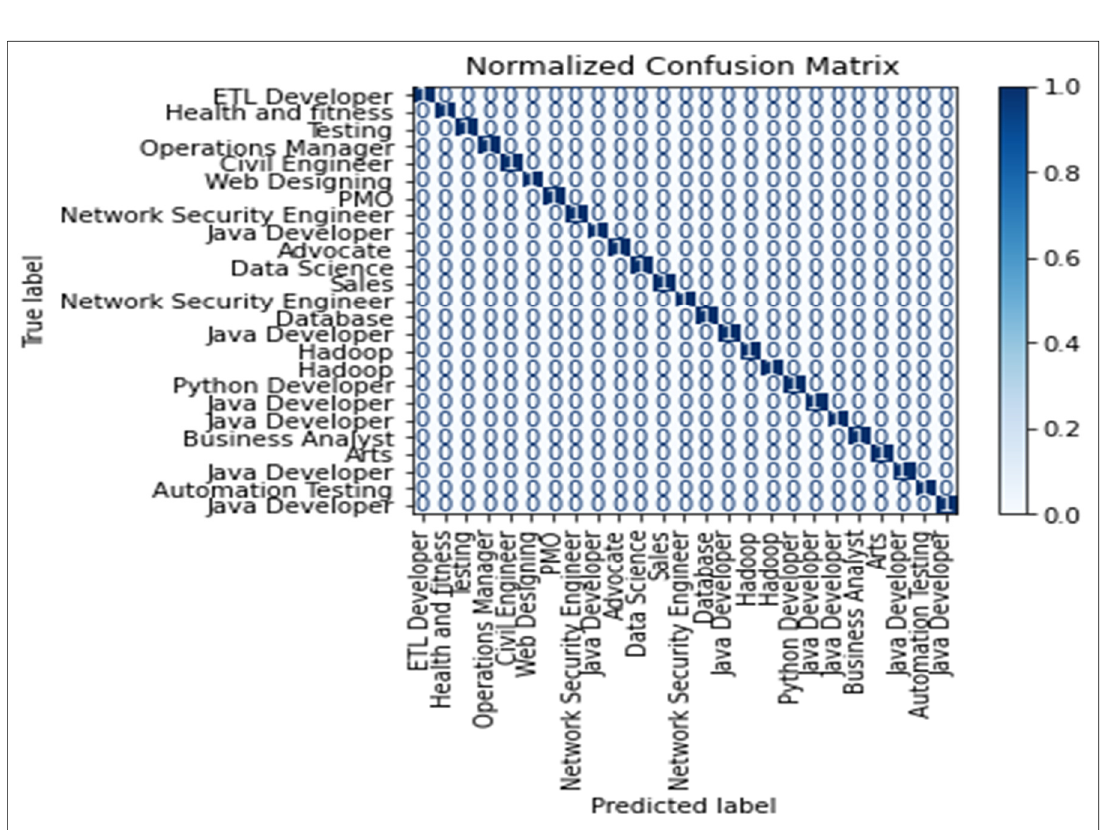
Fig. 9: Normalized Confusion Matrix of Actual vs Predicted class